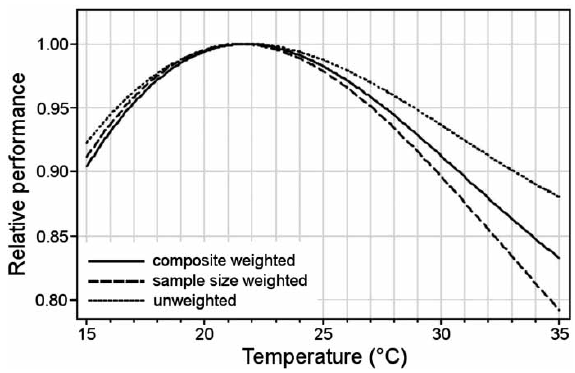
Fig. 1. Normalized relation between performance and air temperature in rooms (Seppa¨nen et al.